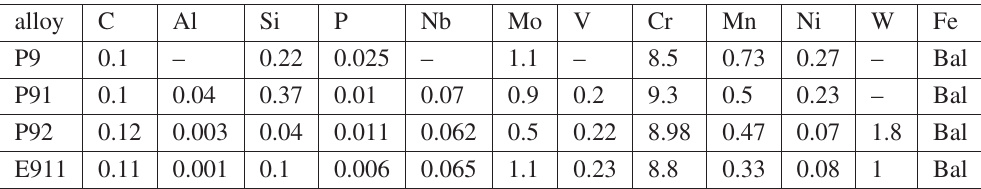
Table 1. Chemical composition of the tested steels (mass %).